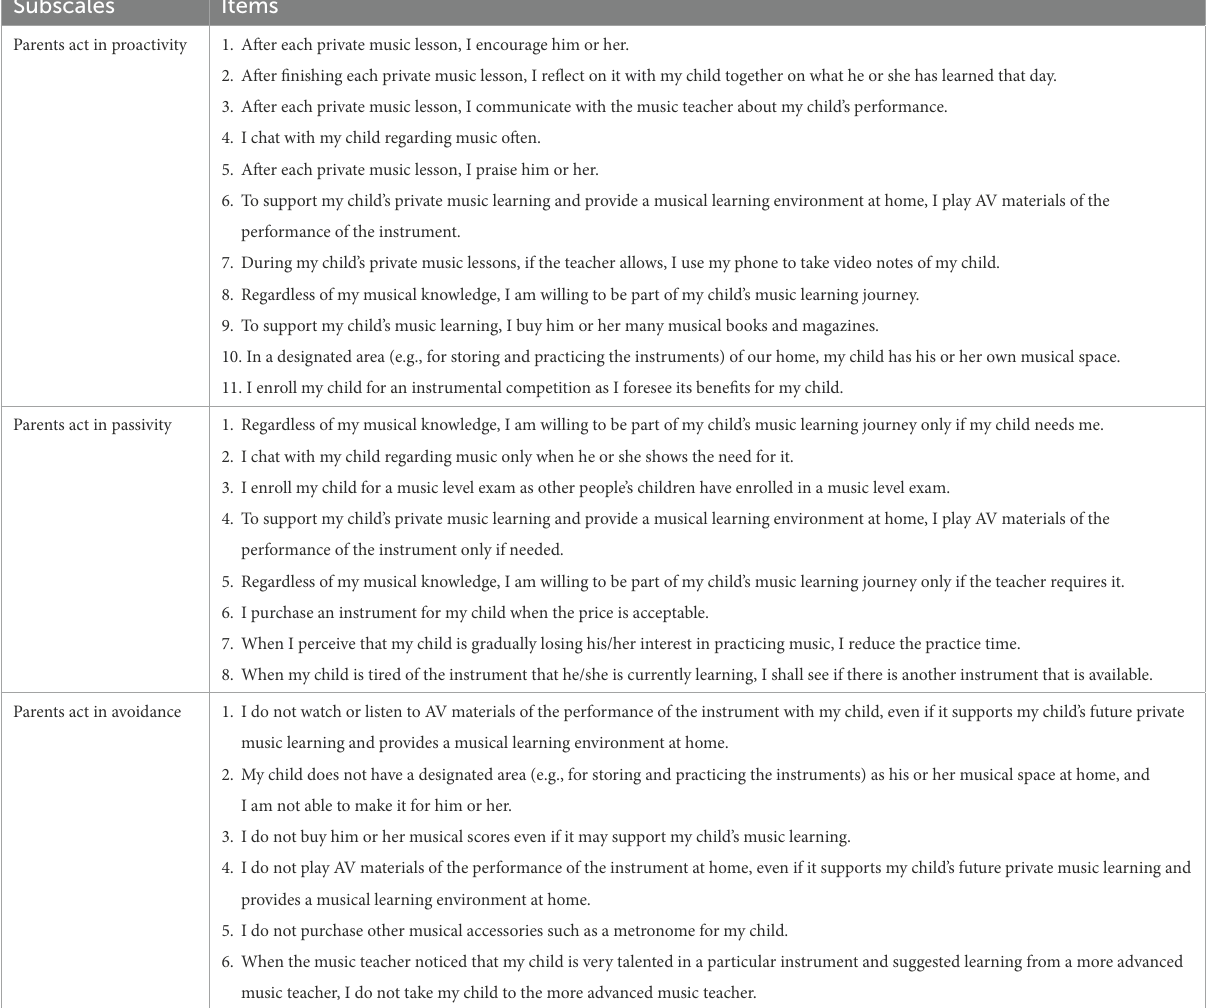
TABLE 3 Parents’ level of actions in private music learning scale (PLAPMLS; 25